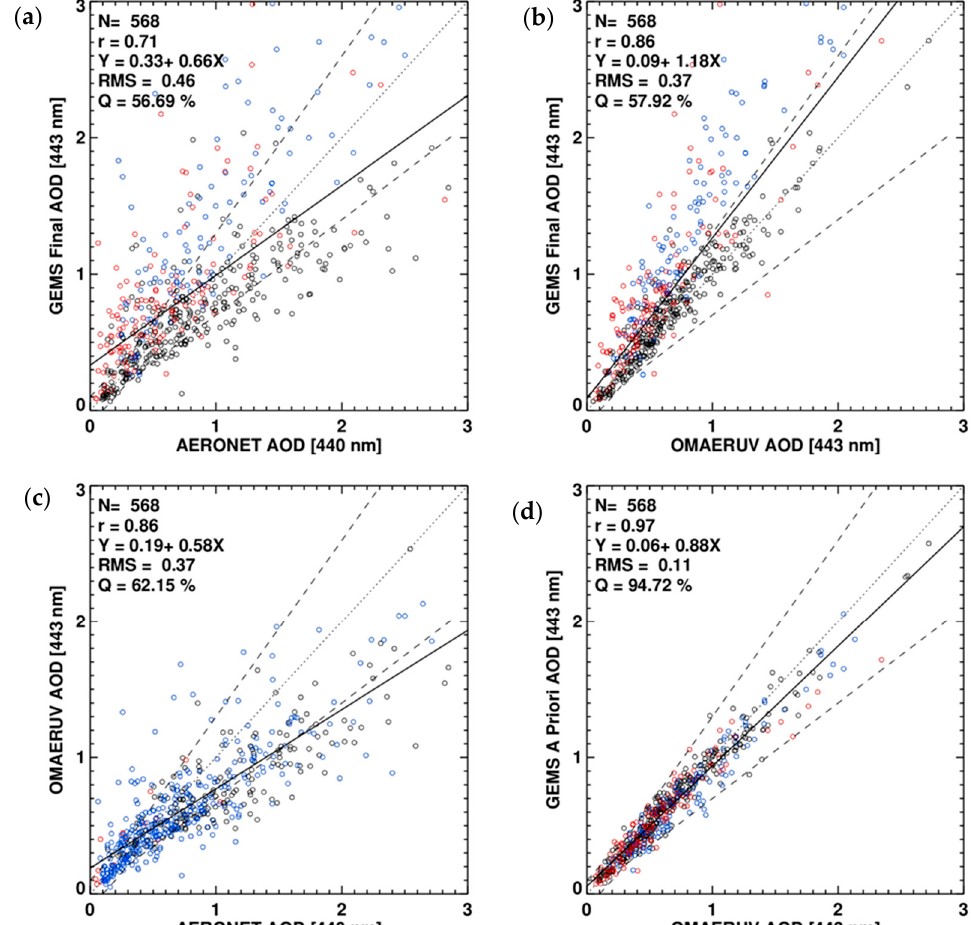
Figure 9. Comparison of ( a ) GEMS and AERONET AOD, ( b ) GEMS and OMAERUV AOD, ( c ) OMAERUV and AERONET AOD and ( d ) GEMS a priori and OMAERUV AOD (443 nm). Colors indicate the aerosol type distinguished by the satellite algorithm shown on the y -axis. Black: HAF (smoke for OMAERUV), red: dust and blue: NA. Dashed lines indicate an uncertainty envelope of ±30% in AOD and dotted lines are 1:1 lines. Black solid lines are linear regression lines for which the equations are shown in the upper left of each panel.